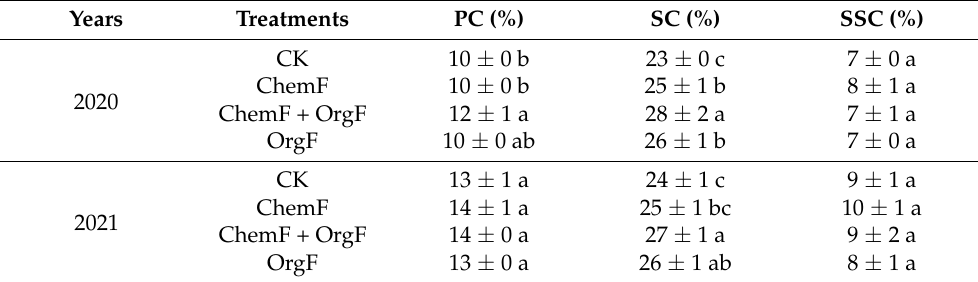
Table 2. The changes in protein content (PC), starch content (SC) and soluble sugar content (SSC) in maize with four treatments in 2020 and 2021. Different letters in the same column indicate significant differences at p =